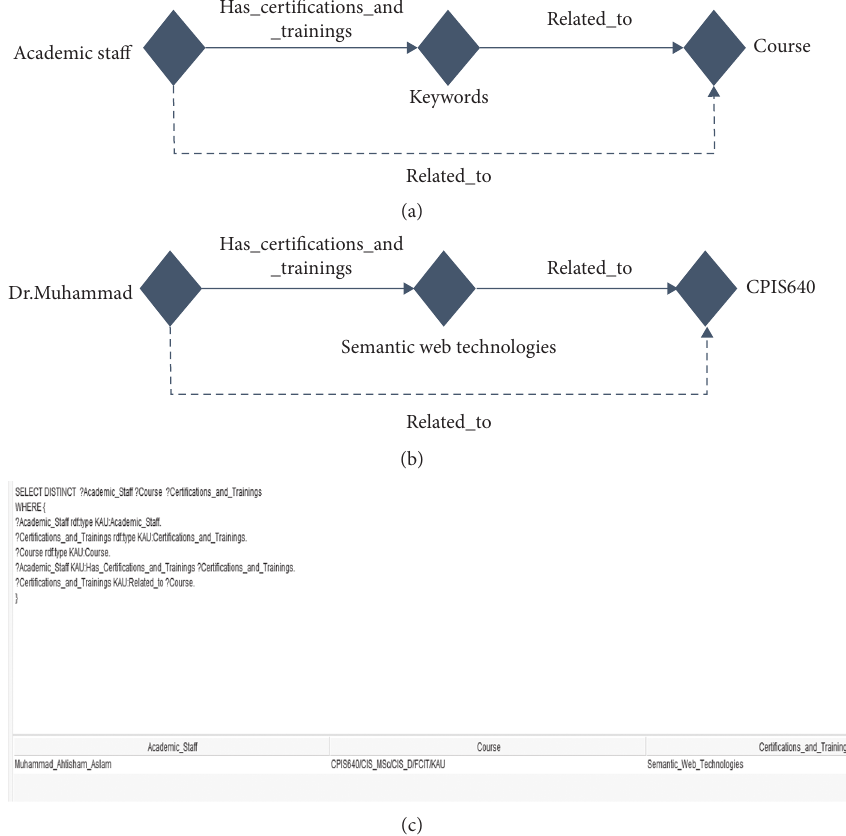
Figure 5: The visualization of Related_to property with certifications and trainings and the results of the